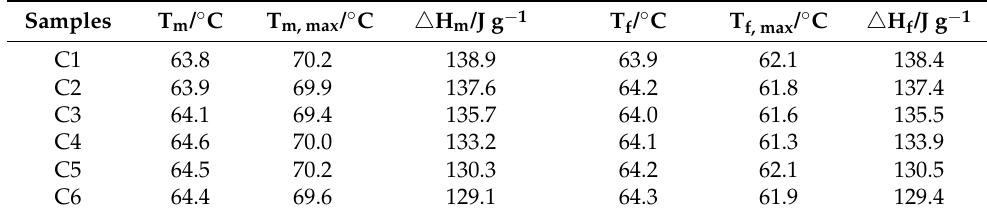
Figure 7. DSC curves of the as-prepared samples. Table 3. Melting-freezing properties for CNT-PE-EPDM/EG base composites.